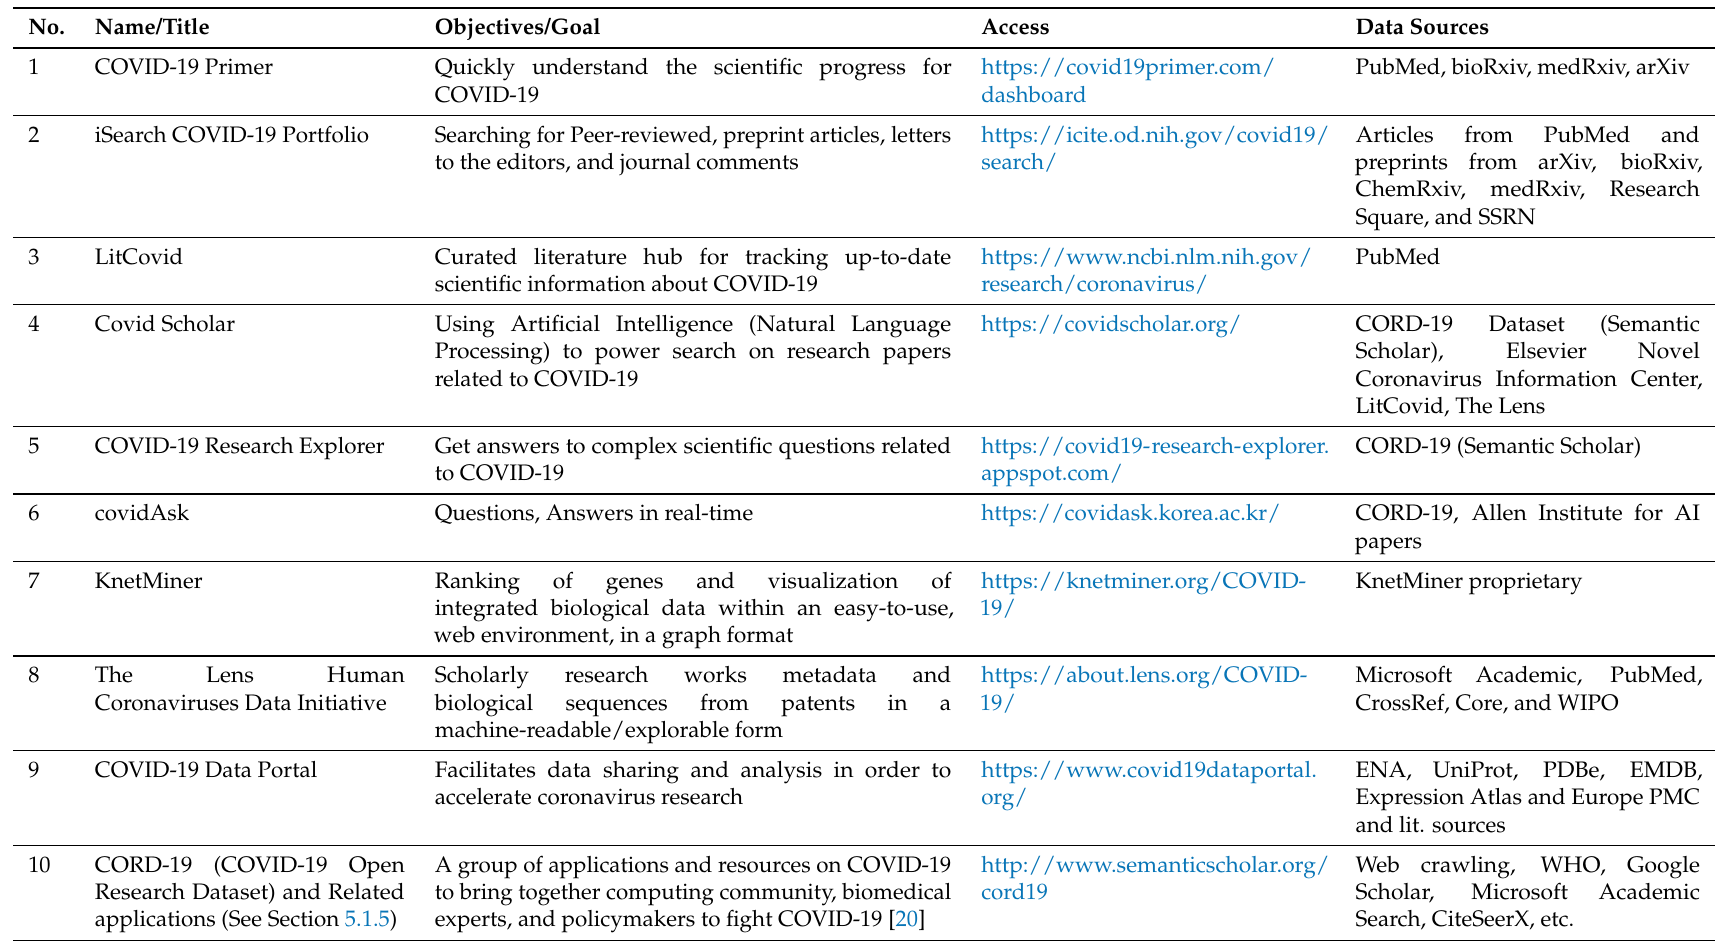
Table 1. Analysis of COVID-19 search portals using selected features (Part 1 of